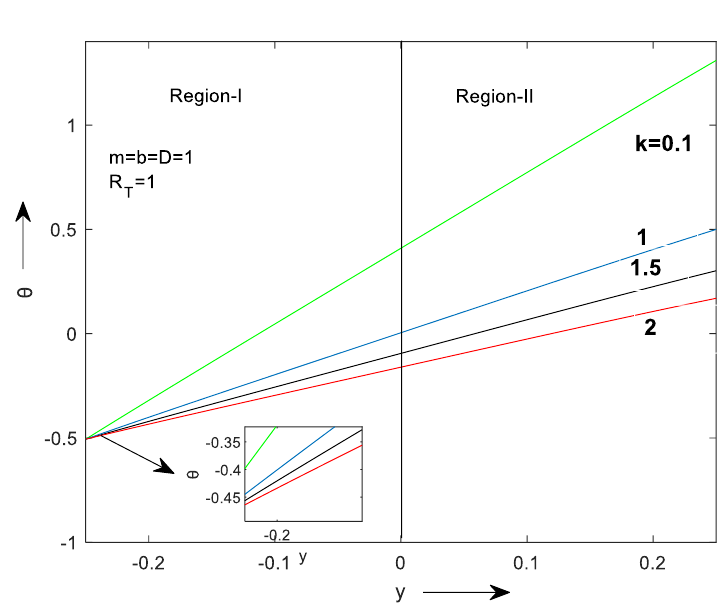
Fig. 7b. Temperature profile for different values of